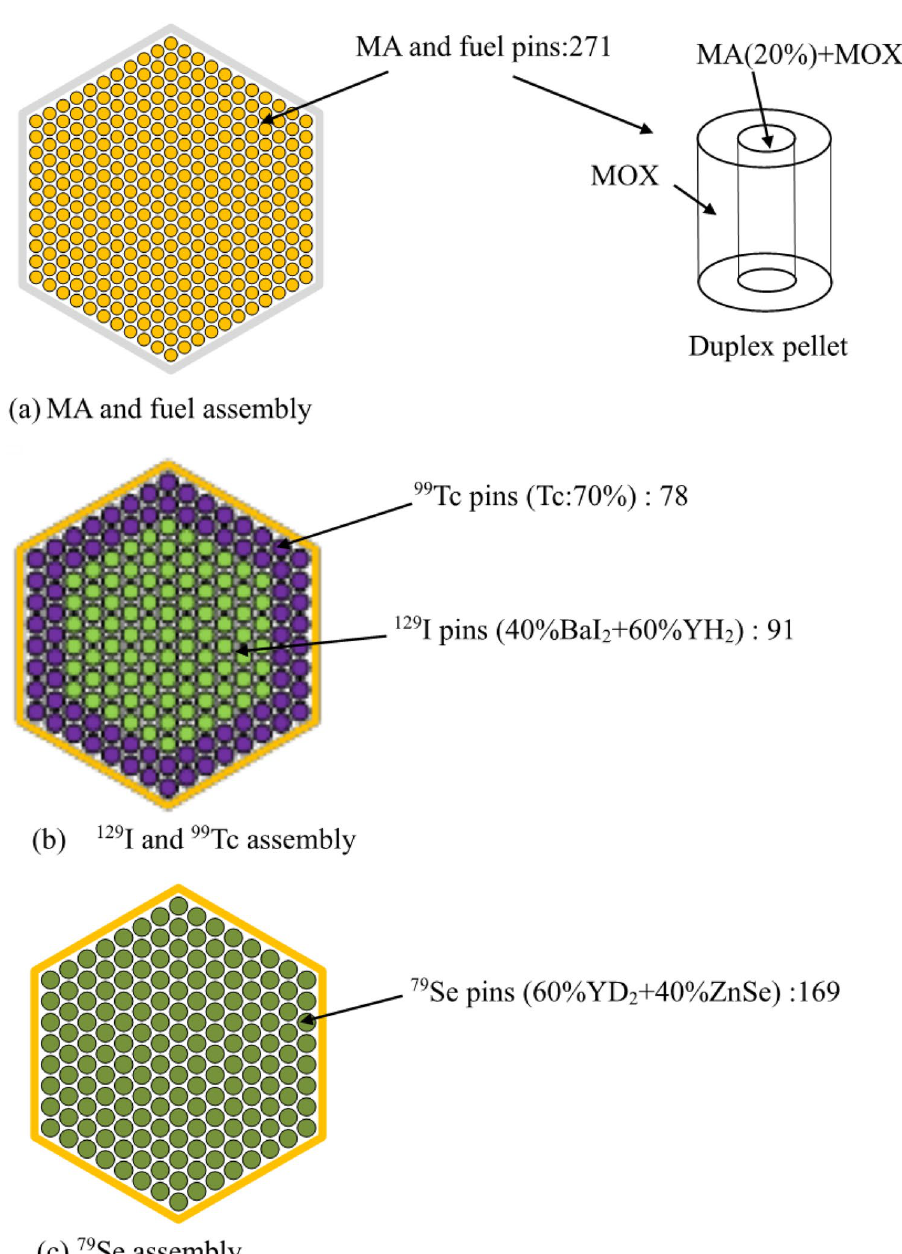
Figure 1. Configurations of MA fuel assembly, 129 I and 99 Tc assembly, and 79 Se assembly. ( a ) Structure of the MA-containing MOX fuel assembly. The number of MA fuel pins in the MA-containing fuel assembly is 271. ( b ) Arrangement of the 99 Tc pins and the 129 I pins in the assembly. Eighty-six 99 Tc and 129 I assemblies are loaded in the first layer of the blanket region. ( c ) A total of 169 pins in the form of mixed ZnSe and YD 2 are arranged in the assembly. Ten 79 Se assemblies are placed in the first layer of the blanket